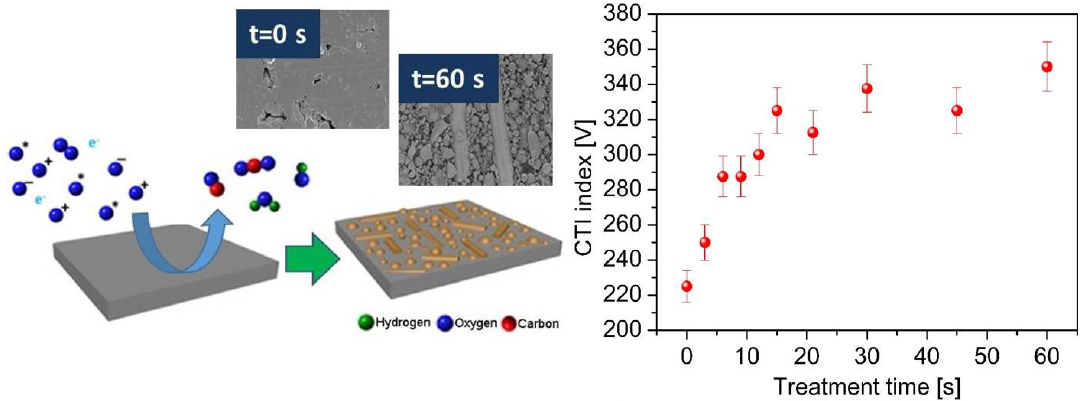
Figure 10. Plasma surface interaction of the glass-filled composite with corresponding SEM images for non-treated and plasma-treated samples for 60 s. The graph represents the variation of comparative tracking index (CTI) performance with plasma exposure time (Reproduced with permission from [101]. Copyright Royal Society of Chemistry, 2015, Year.”).